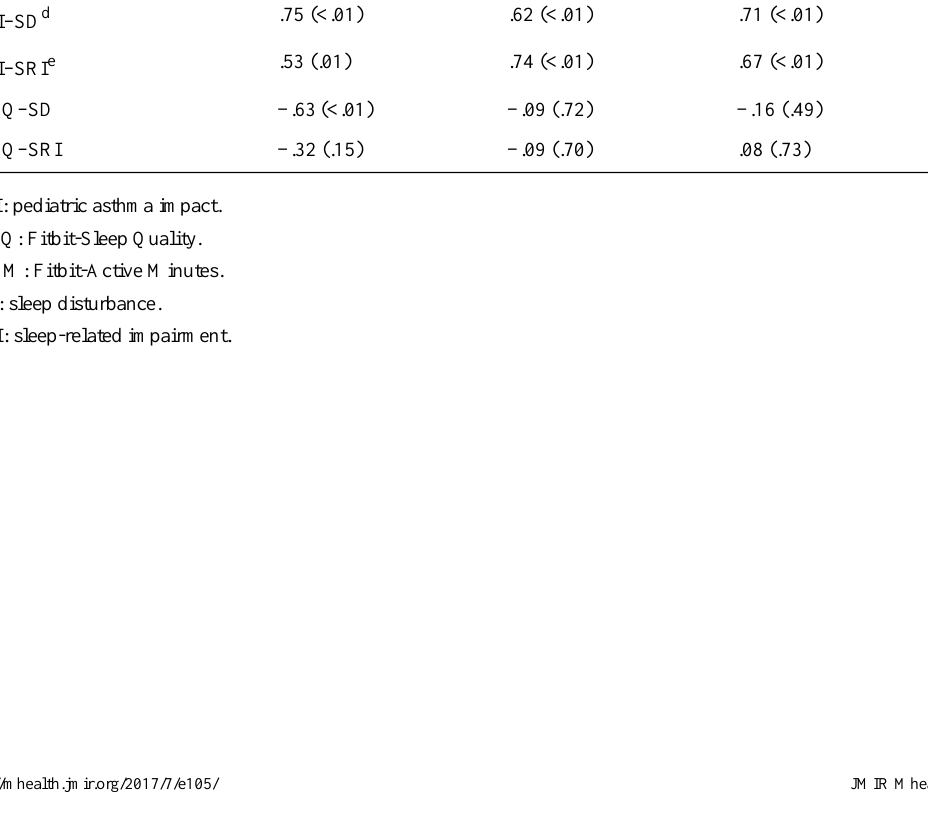
Table 3. Spearman rank-order correlations among the variables of interests across the study period. Week ( P value)Variable Pairs